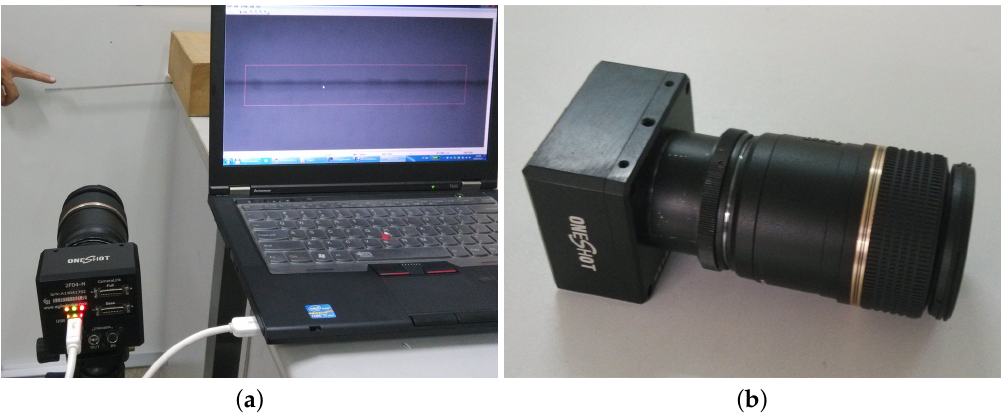
Figure 1. High-speed visual measuring system. ( a ) experimental setup; ( b ) camera head and optical